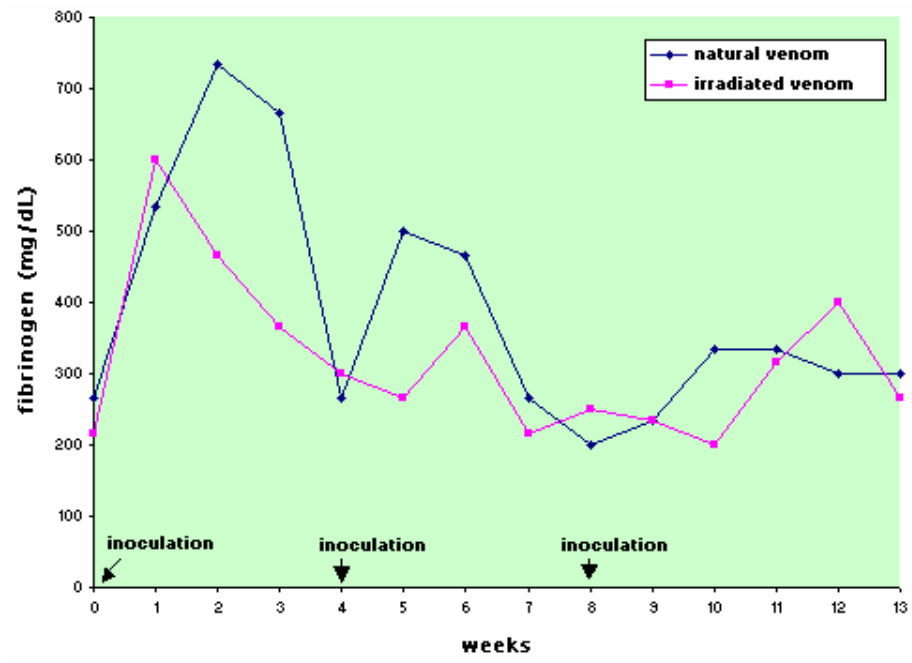
Figure 5 . Mean values of plasma fibrinogen levels (mg/dL) in sheep (n=12) inoculated with -irradiated (IrV) crotalic natural (NV) Cobalt 60